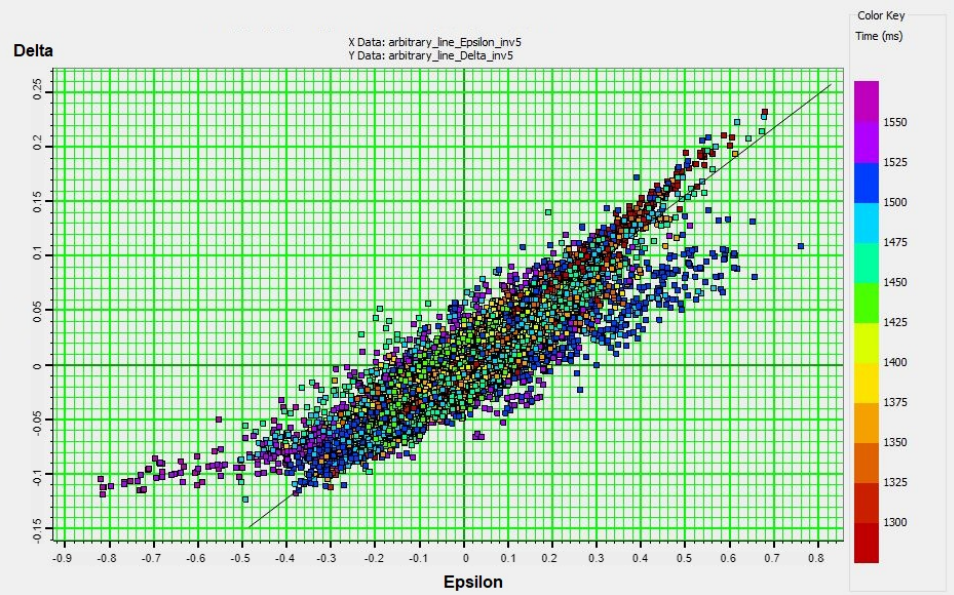
Figure 25. A linear regression plot between Epsilon, on the X-axis, and Delta, on the Y-axis. The data points were obtained from the Epsilon and Delta volumes, which were calculated by applying the MLFN-based Z P and Z S to the impedance-domain Thomsen’s anisotropy